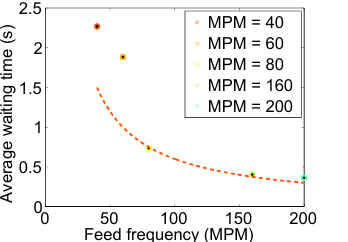
Figure 7. Relation between the driving frequency f input and mean waiting time between observed emigration events W for each exper- imental run. Note the full waiting time distributions for all experi- ments are shown in Fig. 6. The dashed red line shows the expected relation that the mean waiting time is the inverse of the driving fre- quency, W = 1 /f input .